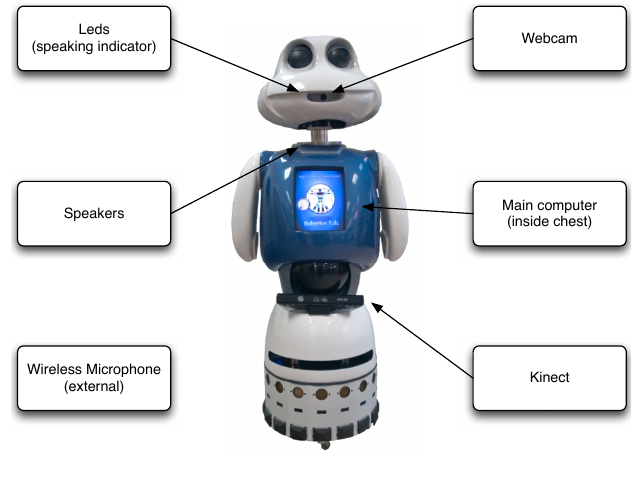
Figure 1. Interaction elements of the robot, Maggie —Among all of them, the learning system relies on the data captured by the Kinect and the wireless